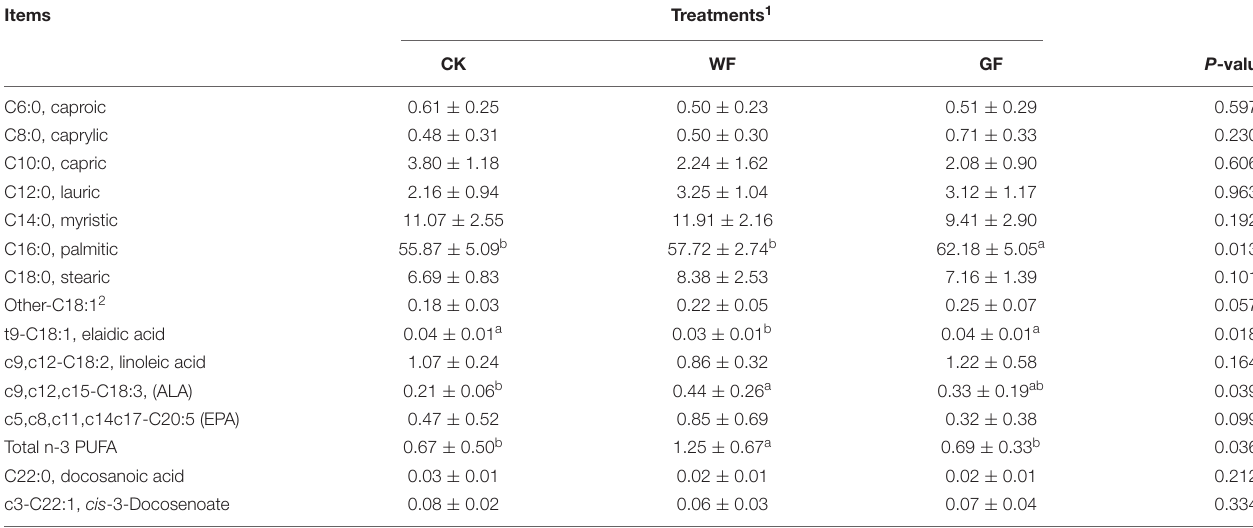
TABLE 2 | Effects of dietary whole or ground flaxseed supplementation on rumen fatty acid (g/100 g total fatty acid).